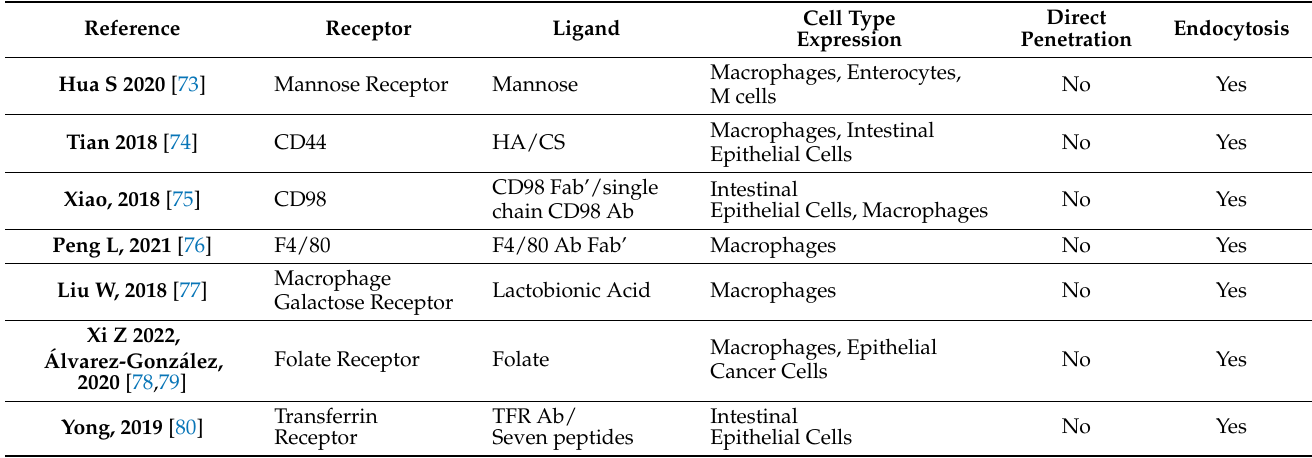
Table 1. Main receptor-ligand interactions used for NPs functionalization in the